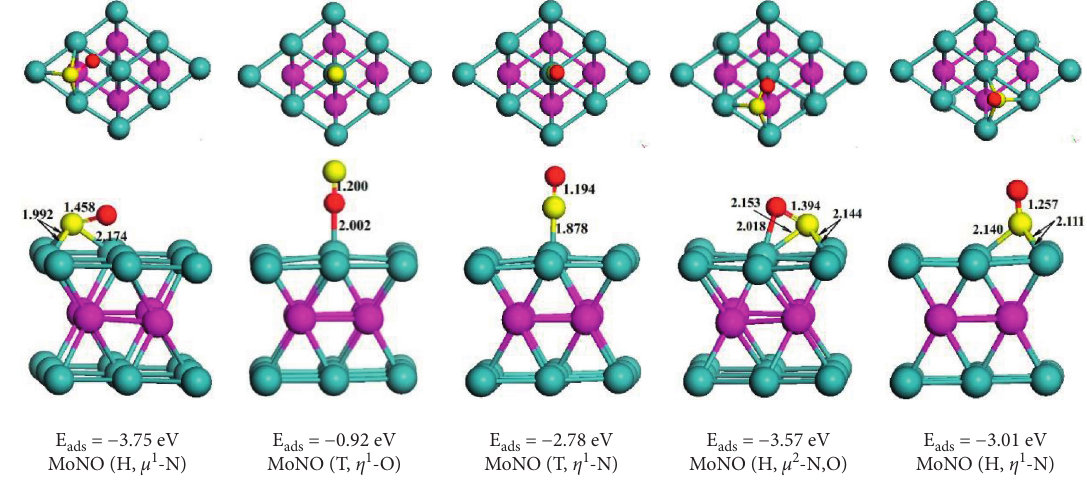
Figure 5: Adsorption structures of NO molecule on the Mo (110) surface. Table 4: Structural parameters of NO adsorption on the Mo (110)